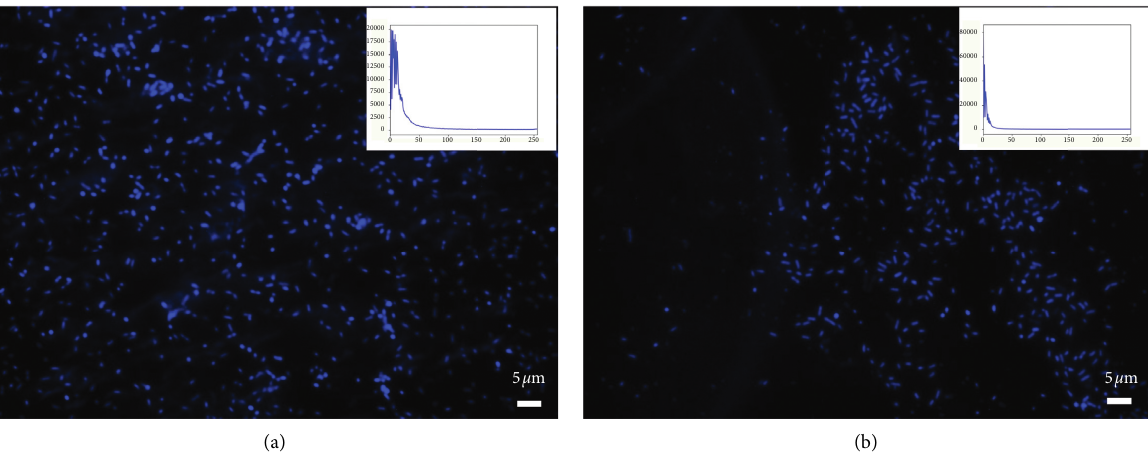
Figure 5: Effect of AgNPs in S. braenderup DNA integrity assessed by fluorescence microscopy with DAPI staining. In the presence of AgNPs, a concentration ratio of 1 :3 for 2hrs (a) and 1:4 for 2hrs